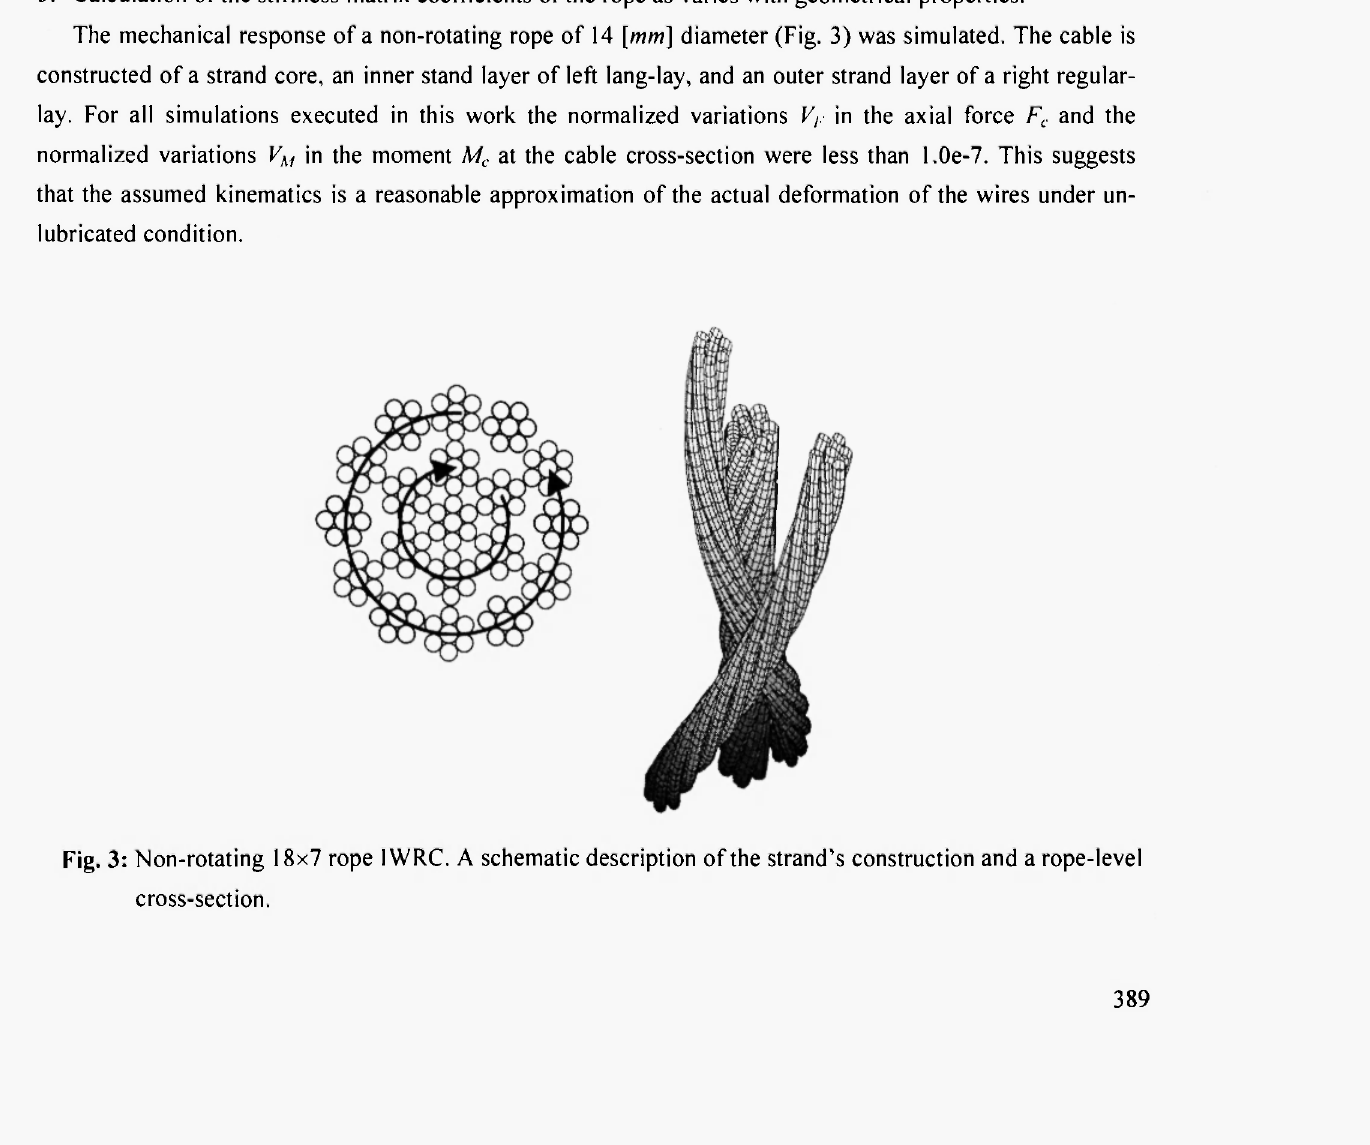
Fig. 3: Non-rotating 18x7 rope IWRC. A schematic description of the strand's construction and a rope-level